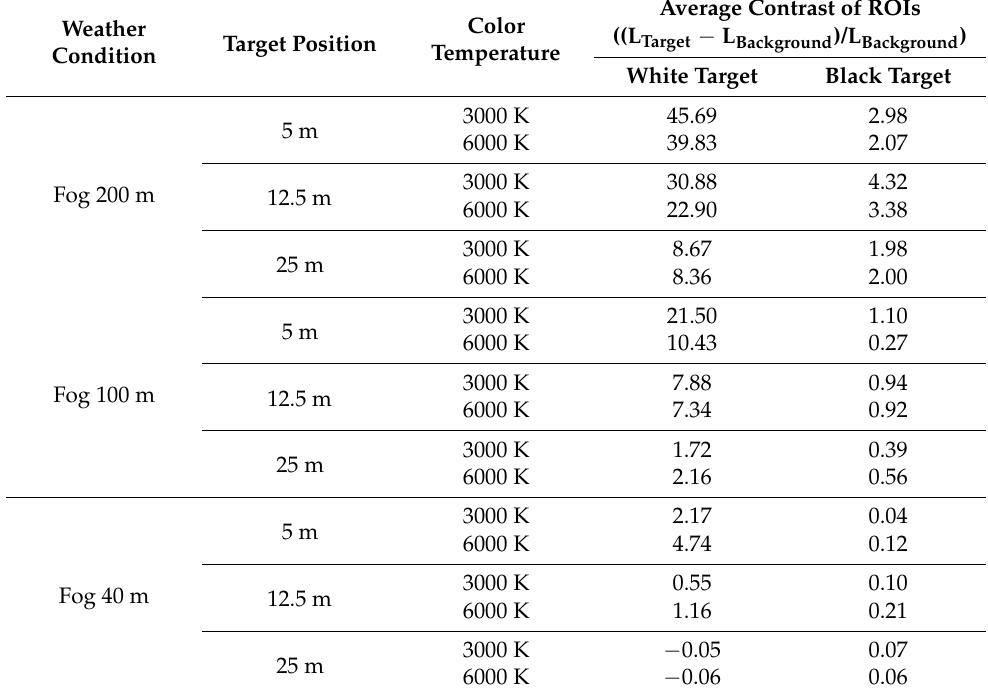
Table 9. Average contrast of ROIs in fog conditions.